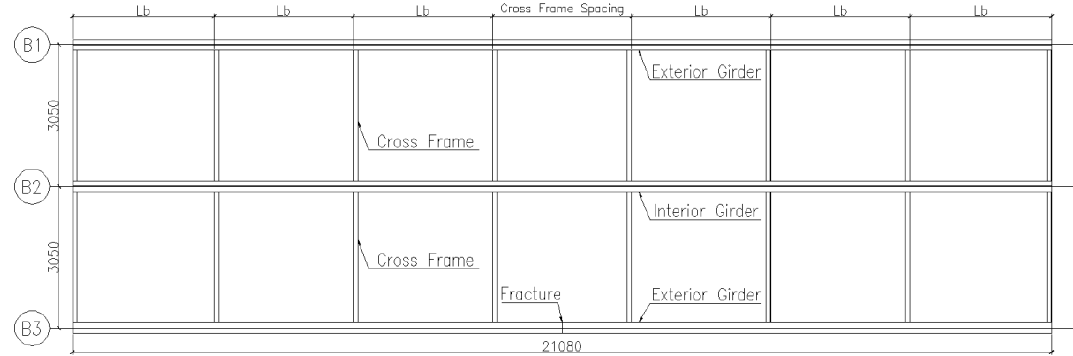
Figure 3. The bridge layout and cross-frame spacing.